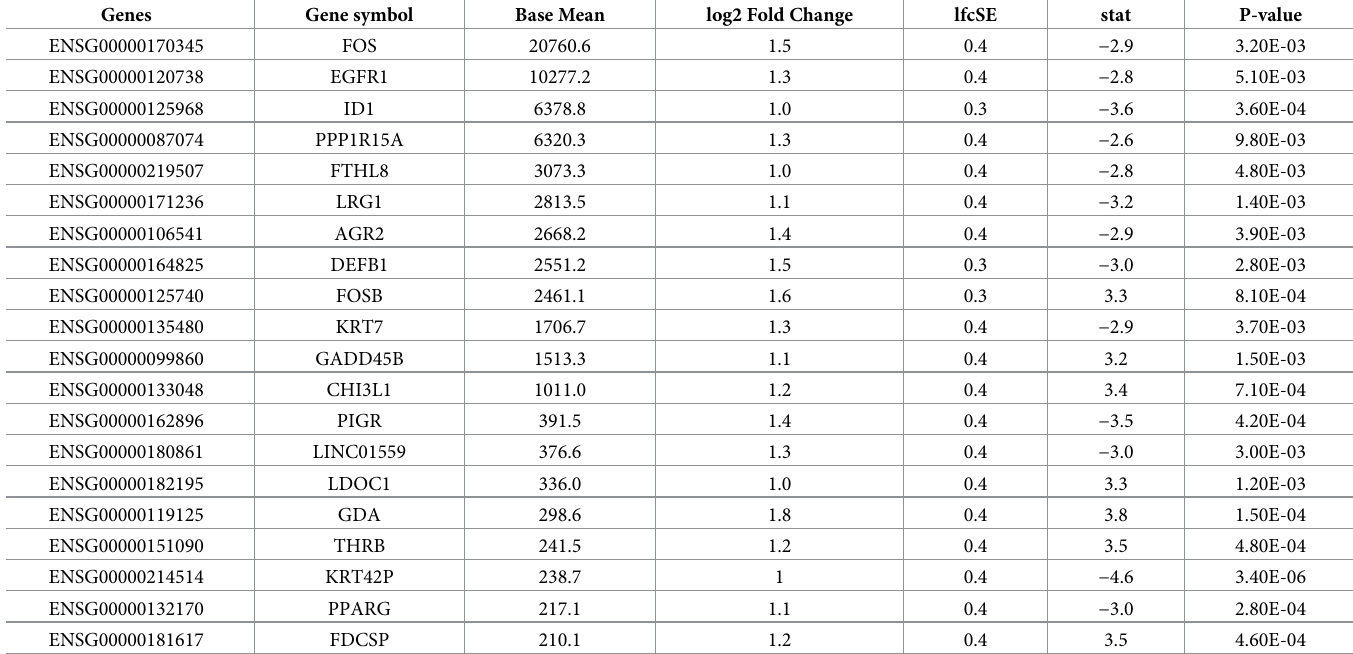
Table 3. Top 20 up-regulated expressed genes in ESCC according to RNA-sequence data.